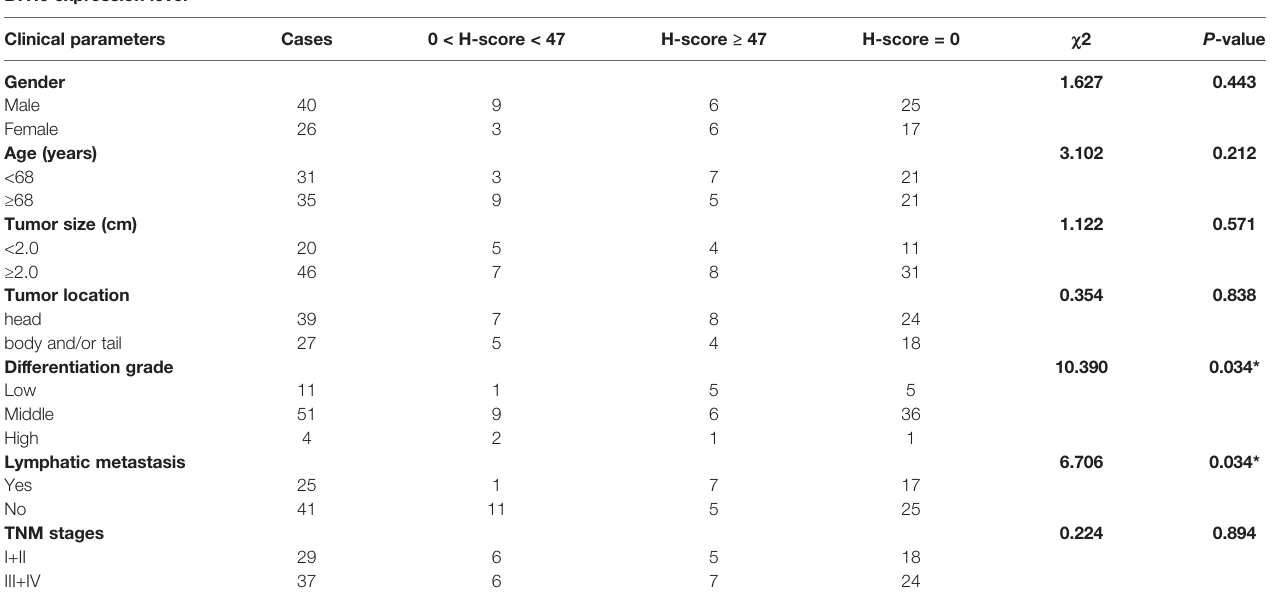
TABLE 1 | Clinical signi fi cance of B7H6 expression on